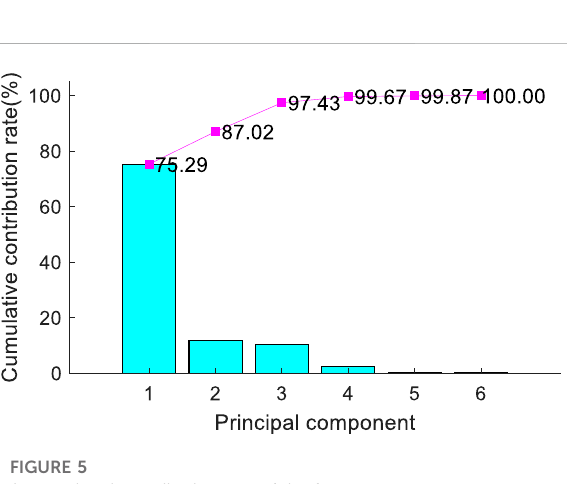
FIGURE 6 Distribution of data in the fi rst layer.